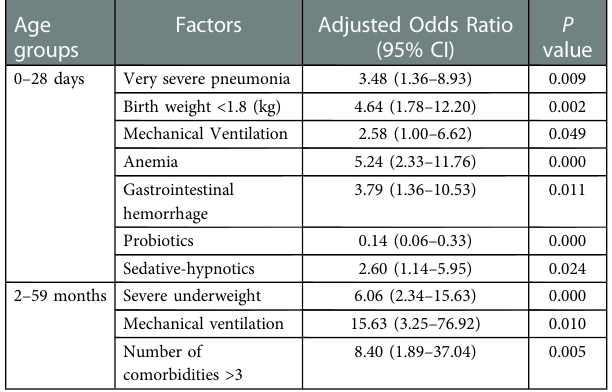
TABLE 4 Risk factors independently associated with death from severe